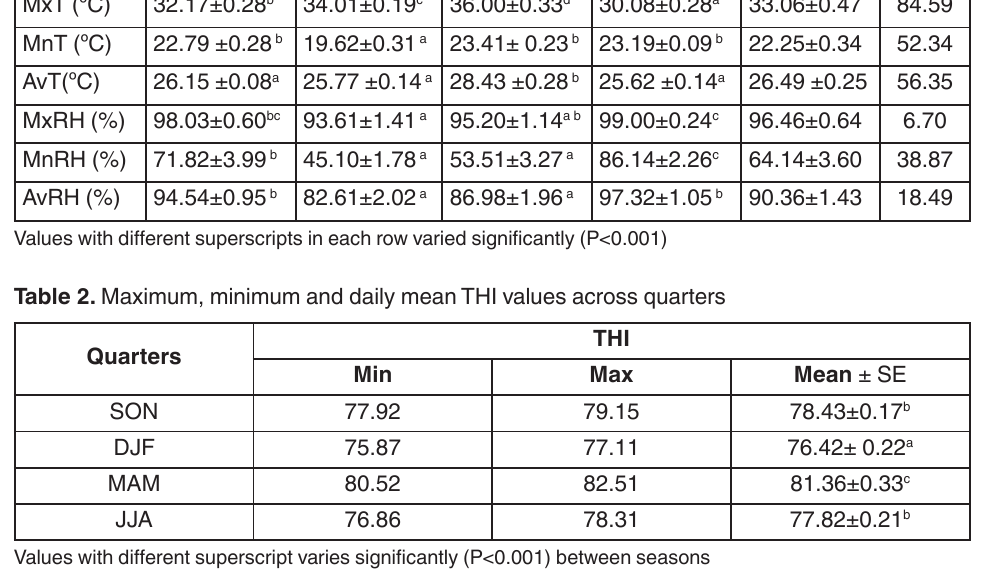
table 1. Maximum, minimum and daily mean values of ambient temperature and relative humidity (Mean ± SE) of the study area during the four seasons